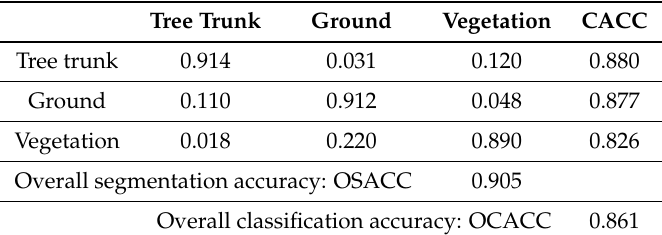
Table 4. Segmentation and classification results for the silver fir ( Abies alba Mill.) tree forest data set (Data_set-3). Tree Trunk Ground